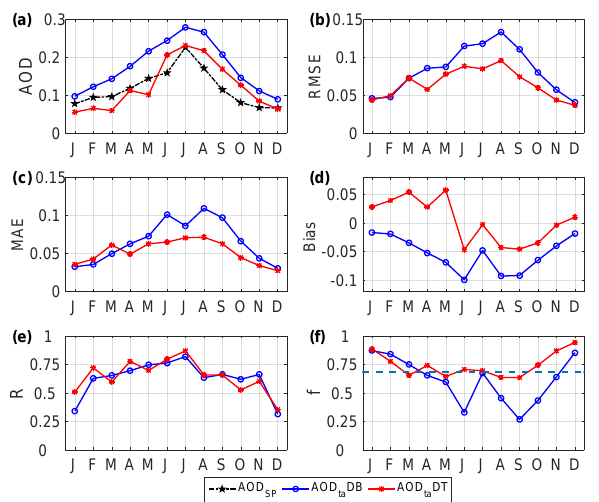
Figure 4. Monthly means and statistics (RMSE, MAE... ) resulting from the comparison between AOD SP and AOD ta for both DB and DT algorithms: (a) monthly means of the AOD SP and AOD ta for both DB and DT algorithms, (b) RMSE for the comparison between AOD SP and AOD ta for both DB and DT algorithms, (c) the same for MAE, (d) BIAS, (e) R and (f) f . The blue discontinuous line at f = 68% represents 1 standard deviation confidence interval for the EE indicator.